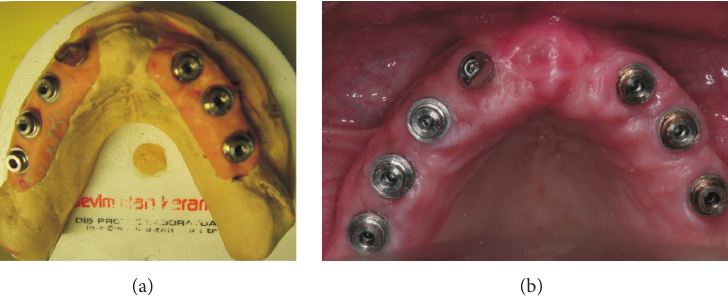
Figure 7: Occlusal view of the abutments (a) on the study cast and (b) intraorally.